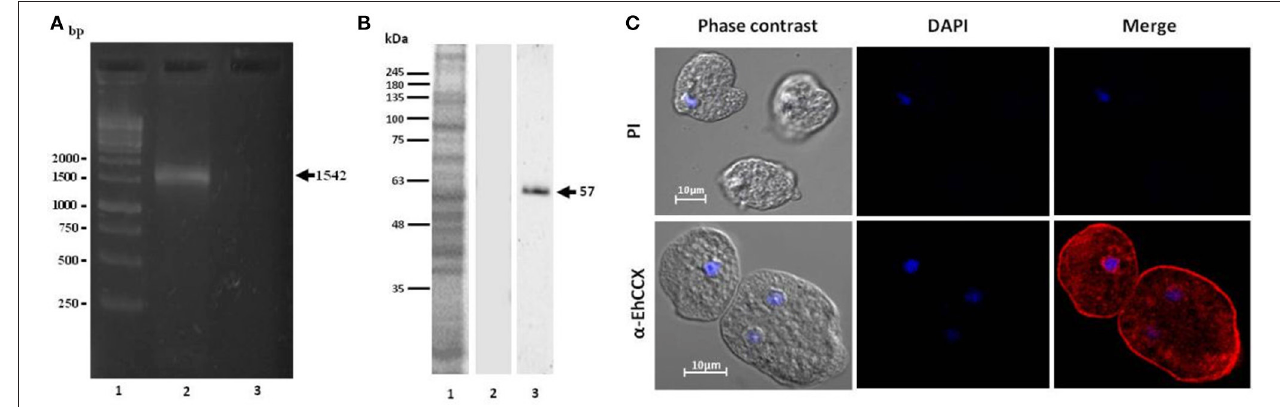
FIGURE 3 | Expression of the Ehccx transcript and immunolocalization of the EhCCX protein. (A) Total RNA was obtained from E. histolytica trophozoites, cDNA was synthesized, and RT-PCR assays were performed using specific primers for Ehccx. Lane 1, 1kb size markers. Lane 2, PCR assay using cDNA as template. Lane 3, PCR using RNA (omitting the cDNA synthesis) as template. (B) A specific peptide of EhCCX was synthesized and inoculated in rats to obtain antibodies against this exchanger. Then, to analyze their specificity, these antibodies were used in Western blot assays on total extracts of trophozoites. Lane 1, total proteins of E. histolytica trophozoites stained with Coomassie blue; lane 2, Western blot assay using the pre-immune serum; lane 3, Western blot assay using α -EhCCX; (C) E. histolytica trophozoites were fixed, permeabilized and incubated with rat antibodies against EhCCX. Subsequently, samples were incubated with Alexa 555-conjugated secondary antibodies. Finally, nuclei were stained with DAPI and samples were analyzed by confocal microscopy. PI, pre-immune serum.